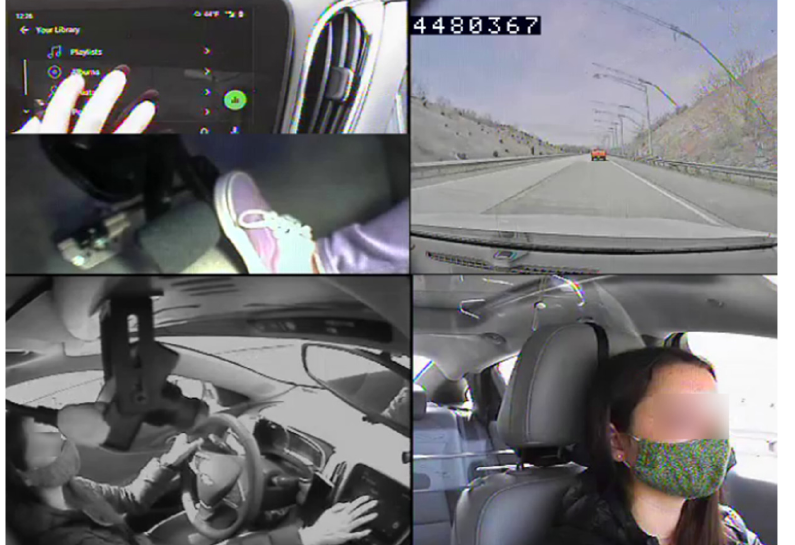
Figure 1. Camera views captured by the DAS: Android Auto TM Interface Display (top left, upper panel), Driver Pedal (top left, bottom panel), Forward Roadway (top right), Over-The-Shoulder View (bottom left), and Driver Face view (bottom right). The driver’s face was blurred in this image to conceal their identity.